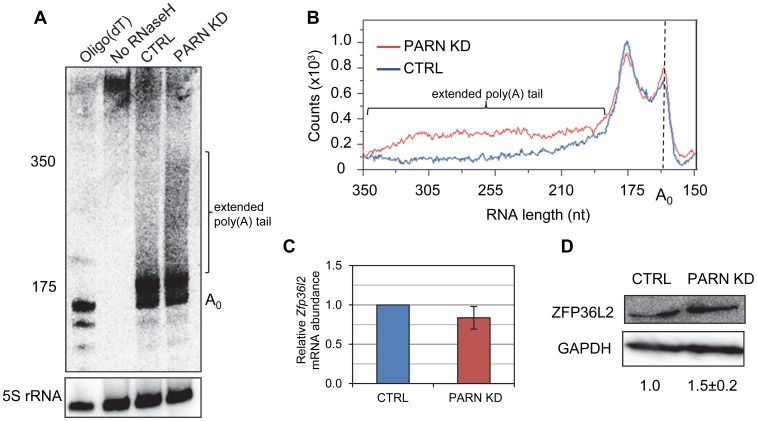
PARN modulates Zfp36l2 poly(A) tail length to reduce expression of ZFP36L2 protein.(A) Total RNA from CTRL or PARN KD cells was treated with RNase H and an oligonucleotide that hybridizes within the 3′UTR of the Zfp36l2 mRNA. The products were separated on a denaturing polyacrylamide gel and detected by northern blotting using a probe against the Zfp36l2 3′UTR. To generate an unadenylated marker, oligo(dT)18 was included in the RNase H treatment for the sample in the first lane. A probe against 5S rRNA was used as a loading control. (B) shows the profile of radioactive counts in the CTRL and PARN KD lanes with approximate size markers indicated on the x-axis. (C) Zfp36l2 mRNA abundance was assessed by qRT-PCR in CTRL and PARN KD cell lines. Error bars represent the standard error of the mean derived from three independent experiments. (D) Western blot showing abundance of ZFP36L2 protein in CTRL and PARN KD cells. Expression was normalized to GAPDH. Relative abundances are indicated along with the standard deviation derived from three independent experiments.